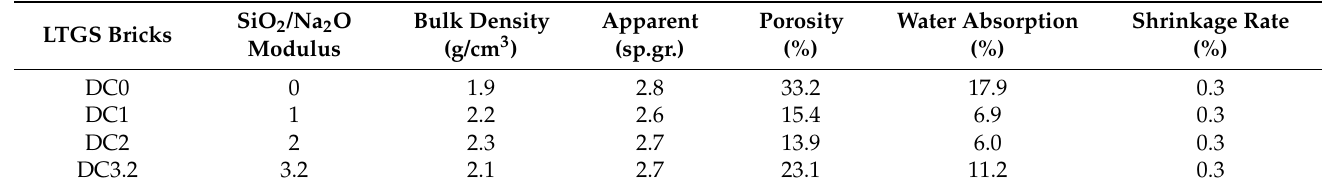
Table 3. Influence of SiO 2 /Na 2 O modulus on the physical properties of LTGS bricks.